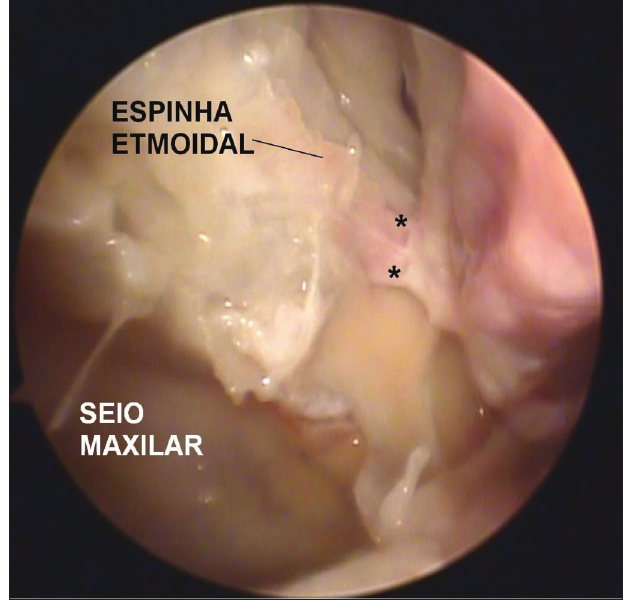
Figura 2. Fotografia da fossa nasal direita evidenciando dois ramos arteriais emergindo do forame esfenopalatino principal. Observar